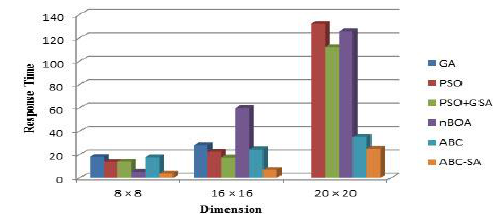
Figure 7. Comparison of response time for the pacman problem.